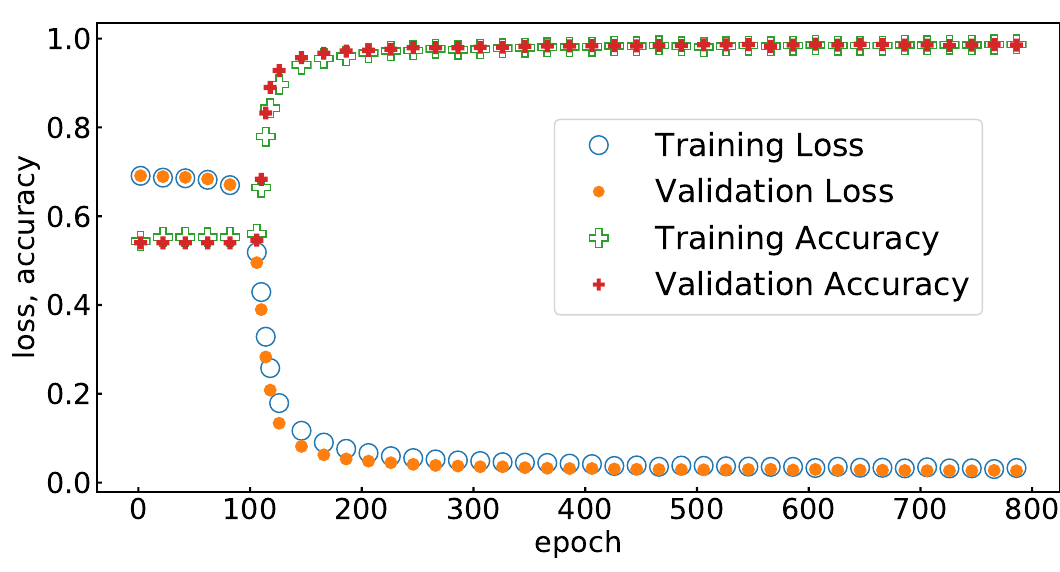
Figure 5 . Training and validation losses and accuracies for UrQMD generated Au+Au collisions at p s = 11